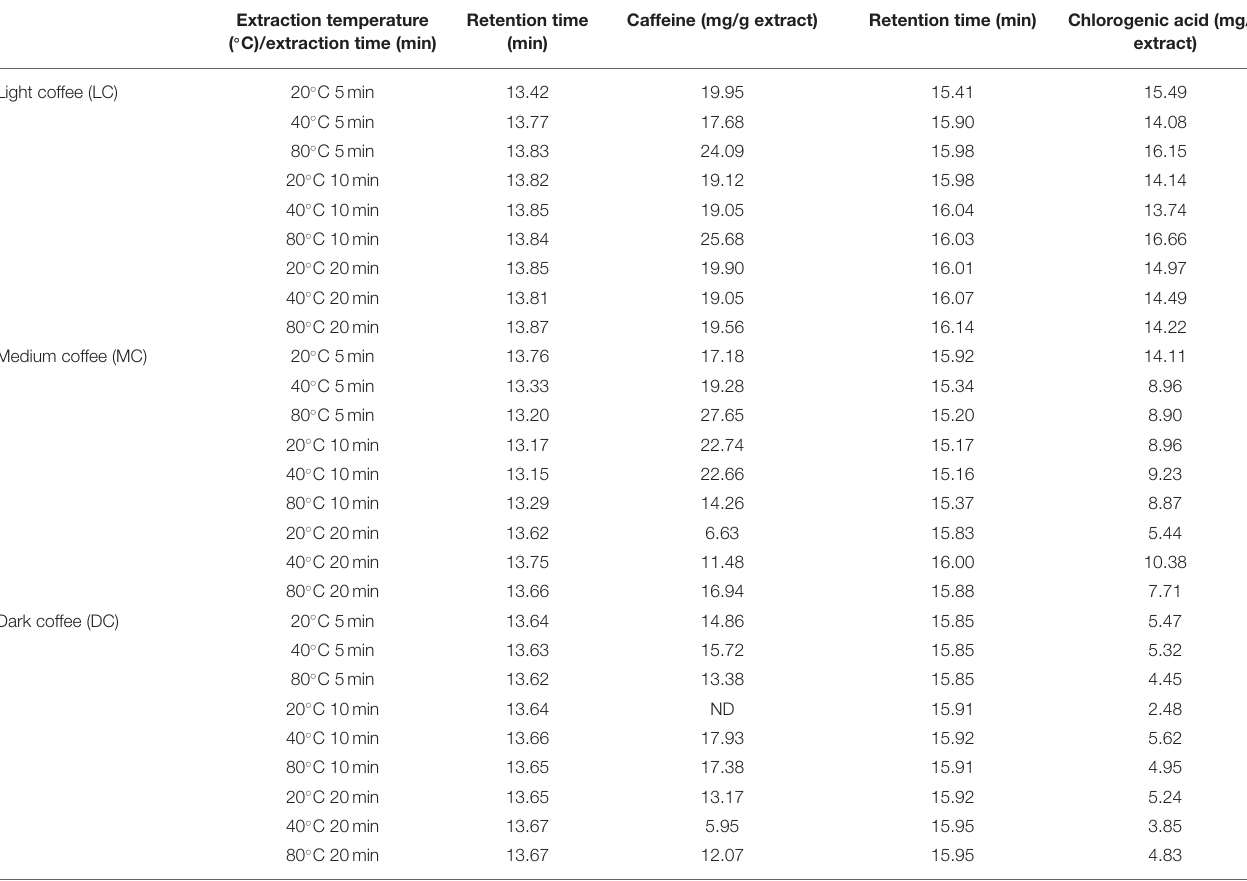
TABLE 3 | Quantitative high-performance liquid chromatography (HPLC) analysis caffeine and chlorogenic acid in coffee roast extracts.